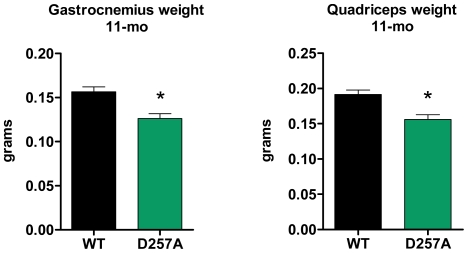
D257A mice display significant skeletal muscle loss.At 11 mo of age, gastrocnemius (n = 22 per group, *p<0.001) and quadriceps (n = 22 per group, *p<0.001) mean muscle mass in D257A mice is significantly decreased compared to age-matched WT. Error bars represent SEM.